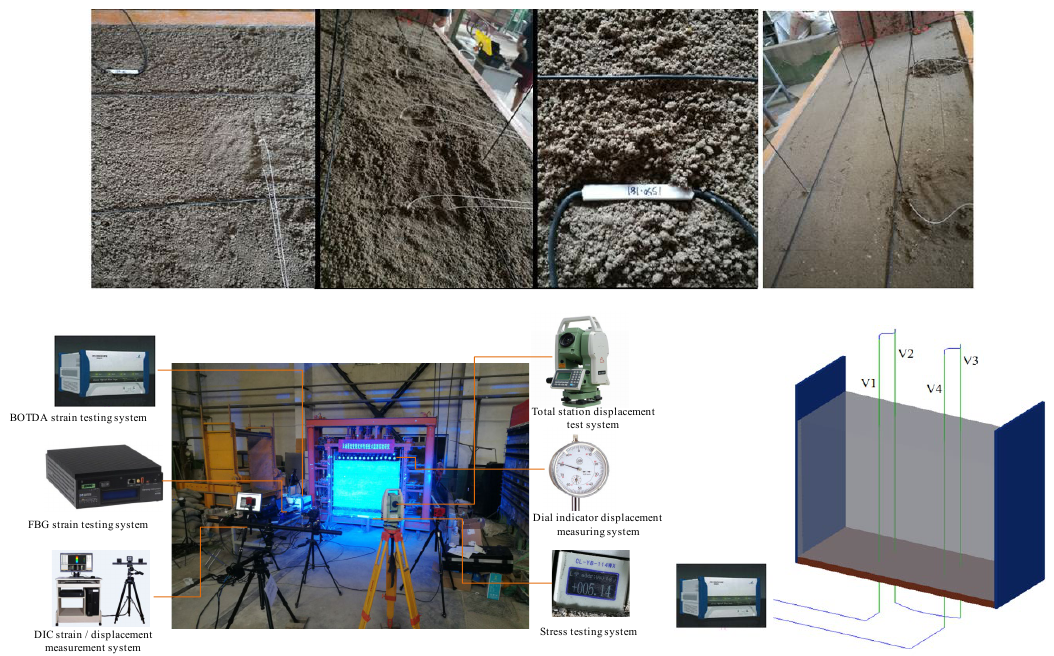
Figure 8. Model test system and vertical optical fiber arrangement.